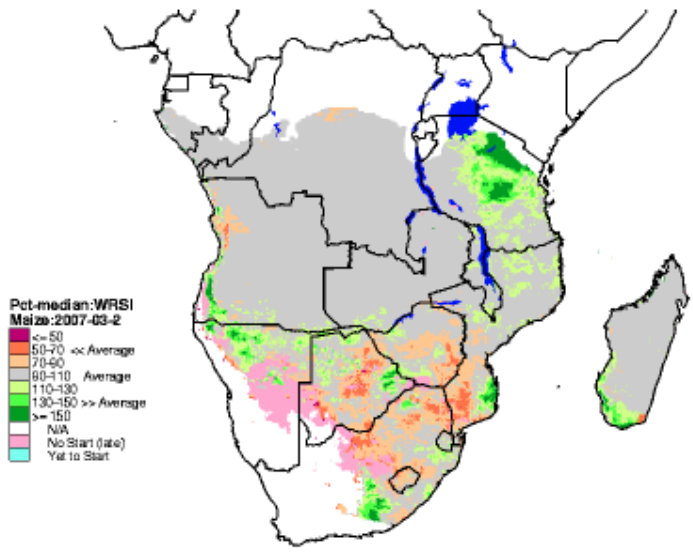
Figure 13. WRSI anomaly as of the 2 nd dekad of March, 2007 for the same southern Africa